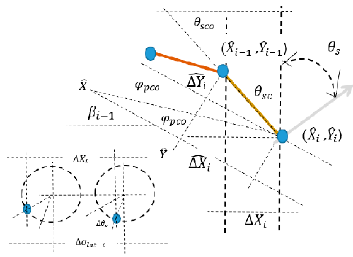
Figure 13. Trigonometric relationships of the mechanism.